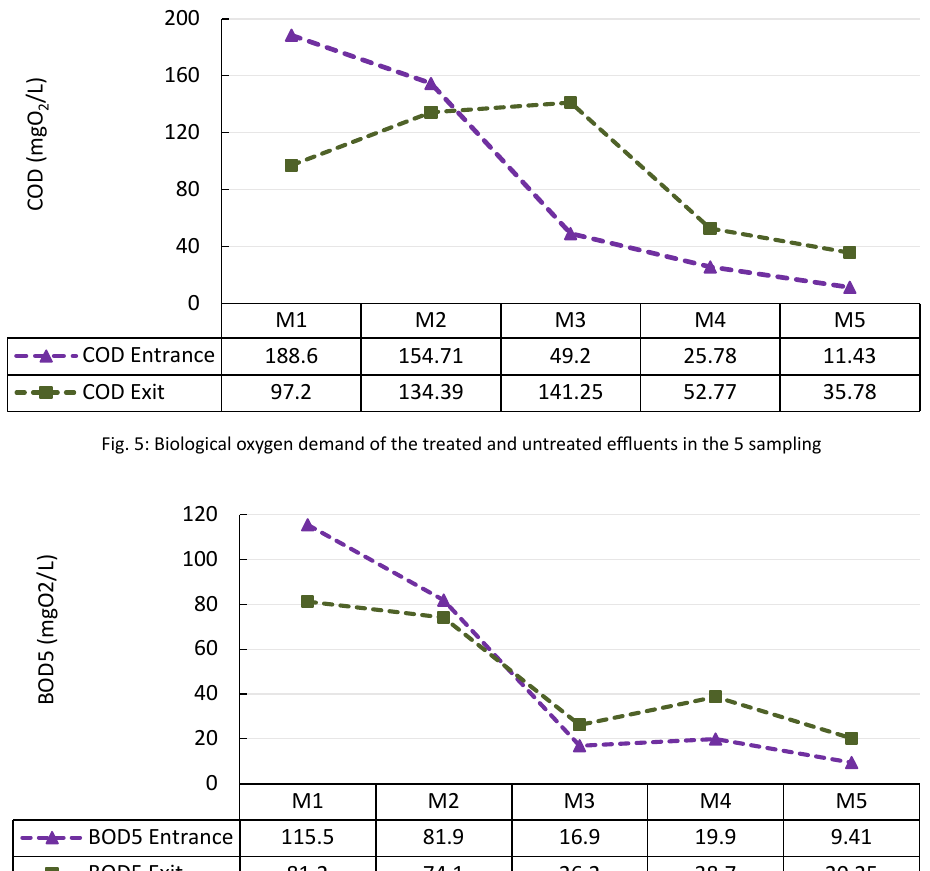
Fig. 5: Biological oxygen demand of the treated and untreated effluents in the 5 sampling